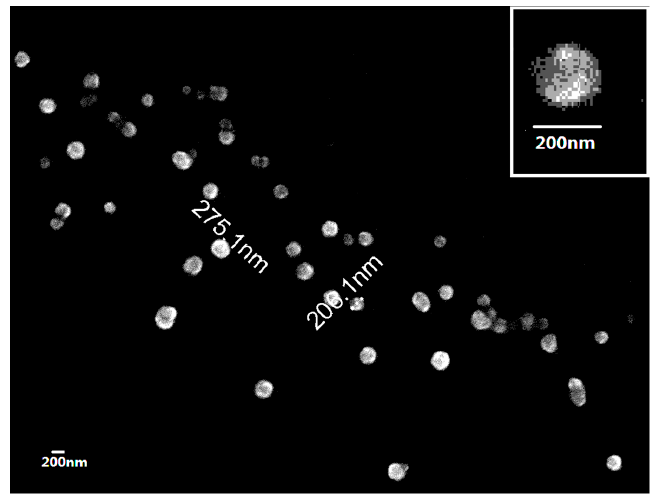
Figure 2. Nanoparticle pattern under field emission scanning electron microscope.